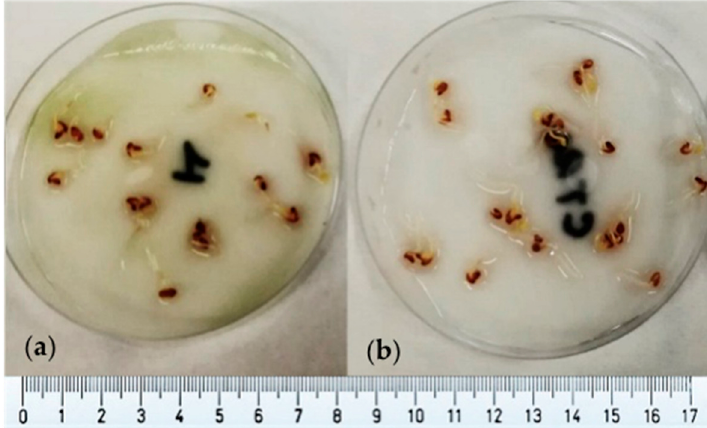
Figure 2. Germinated seeds using A. platensis extracts ( a ) vs. water ( b ) used as a control.